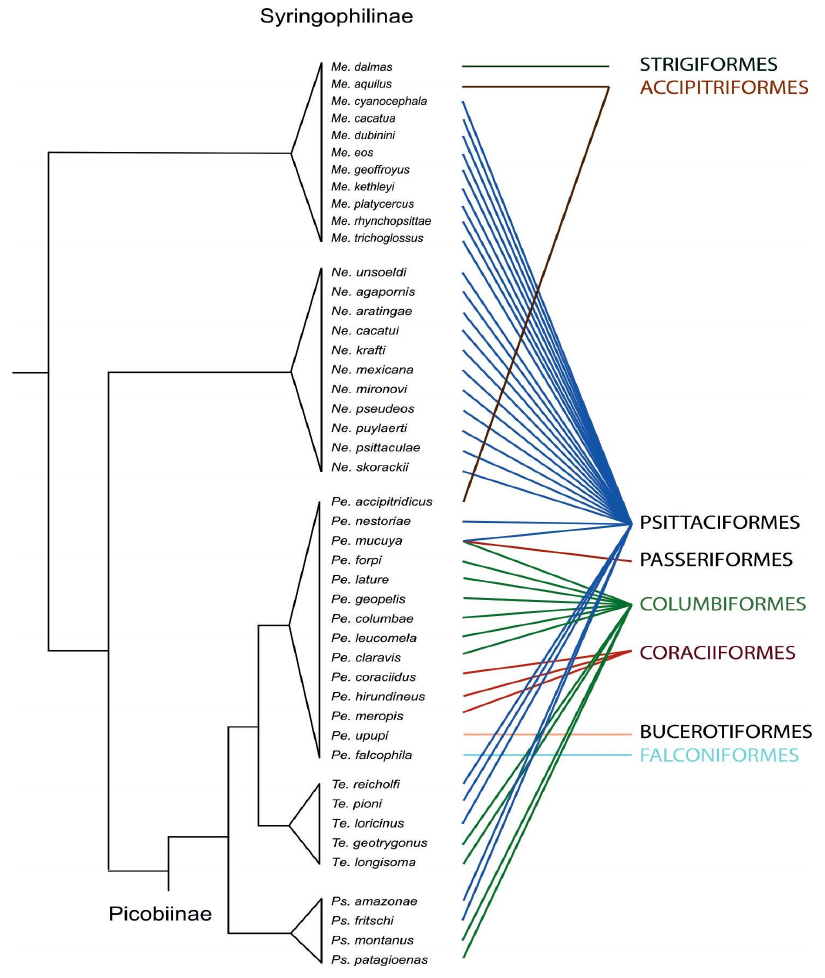
Figure 4. Host association of the species in the particular genera of the subfamily Syringophilinae recorded from parrots.